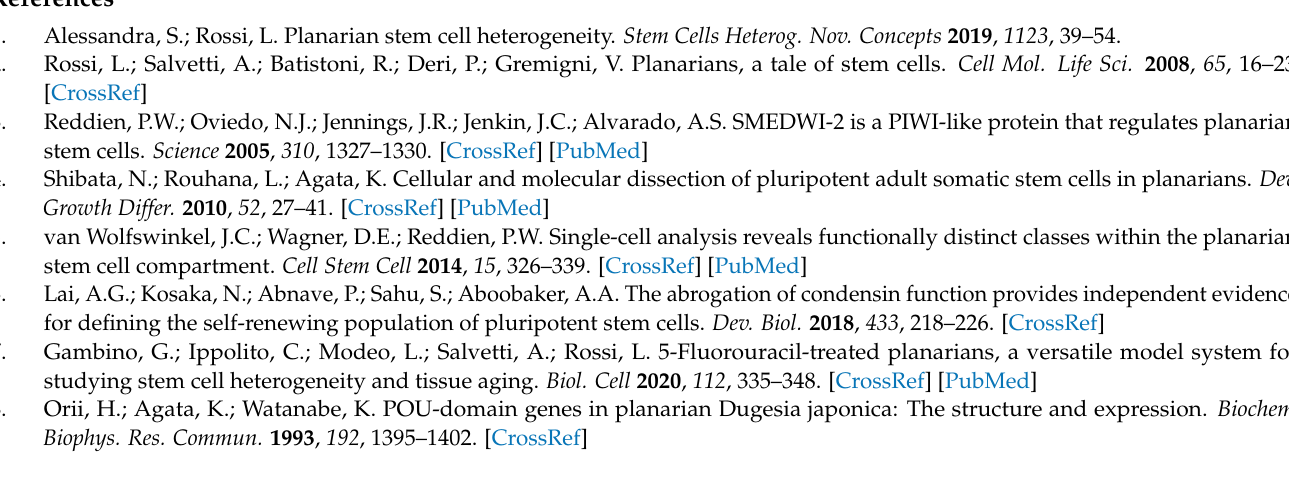
treatment. Representative images of DjsoxP-1 in situ hybridization in 2-day-old regenerating control and treated animals sacrificed 15 days after the first 5FU treatment. Scale bar corresponds to 500 µ m. Figure S6: Direct Red 80-/Fast Green-stained sections obtained from hybridized specimens. Images on the right are magnifications of the boxed region depicted in the corresponding images on the left. Scale bars correspond to 100 µ m (for low magnification) and 25 µ m (for high magnification). Table S1: (A) Distribution of 5FU specimens with respect to DjsoxP-1 signal intensity vs control specimens 7 and 10 days after treatment. MGV=mean grey value; (B) Distribution of 5FU specimens with respect to DjsoxP-1 expression pattern 22 days after